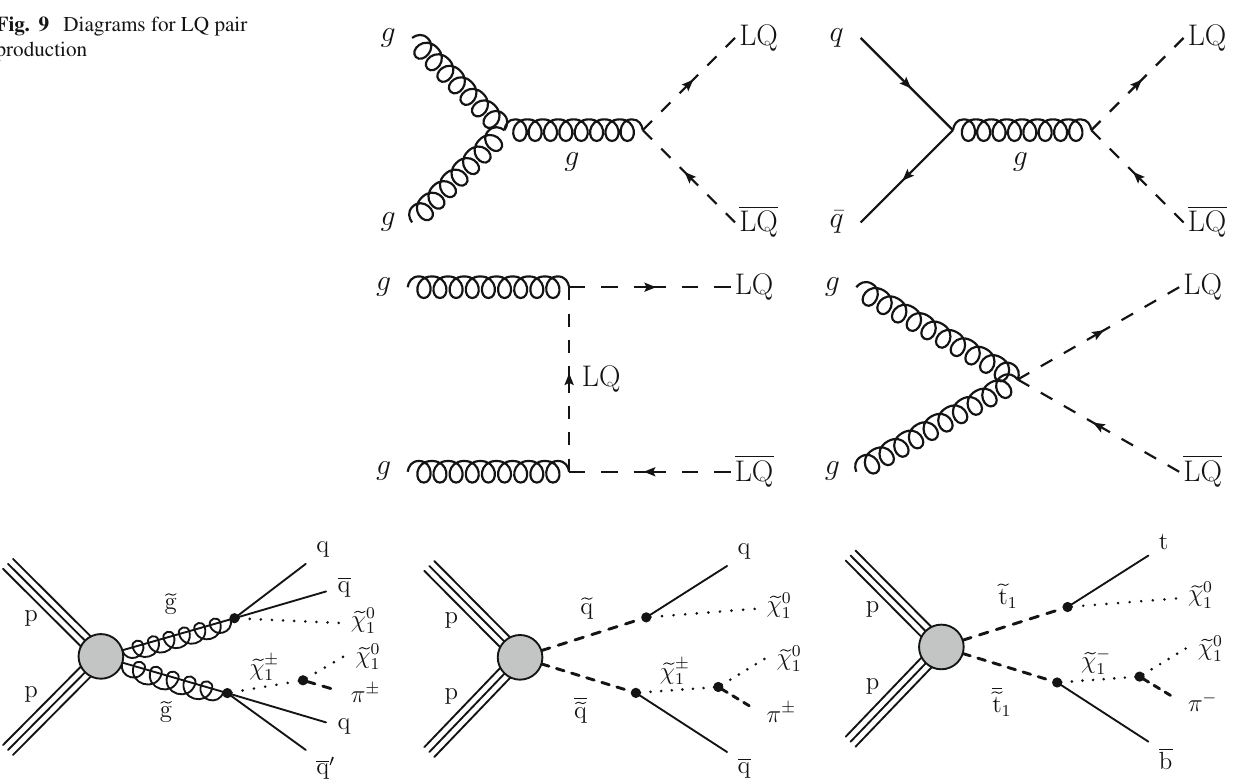
Fig. 10 Diagrams for direct (left) gluino, (middle) light-flavor (u, d, s, c) squark, and (right) top squark pairproduction, where the directlypro- duced gluinos and squarks can decay via a long-lived ˜ χ ± we assume a 1/3 decay branching fraction to each ˜ χ 0 each gluino decays to light-flavor quarks. For squarks, we assume a 1/2